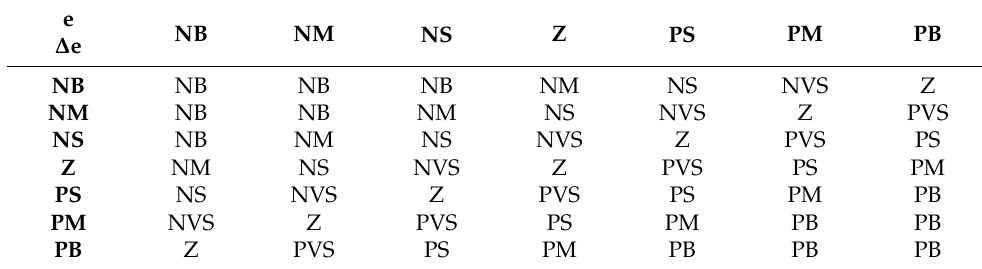
Table 5. Rule base for fuzzy logic, controller-based induction motor